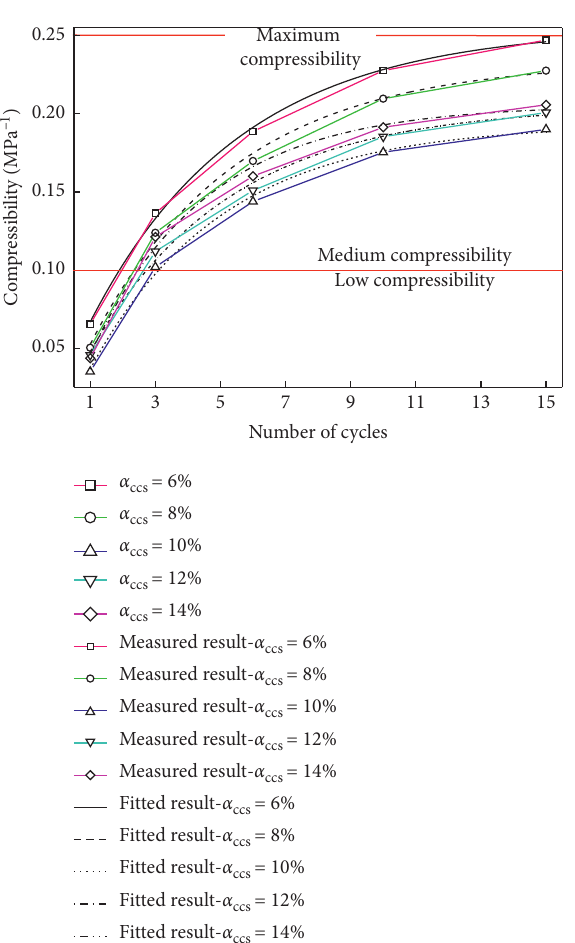
Figure 5: Relationships between the compression coefficient and the number of drying-wetting cycles.